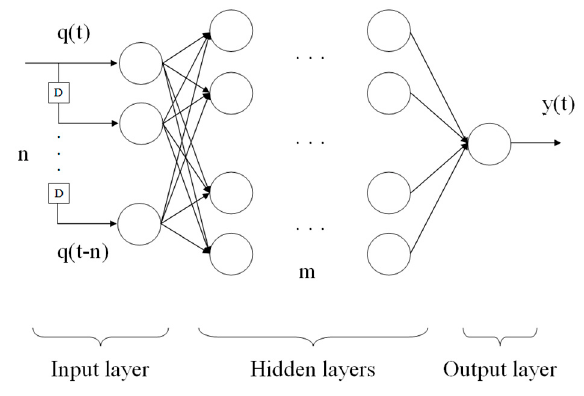
Figure 4. Structure of a Time ‐ delay neural network.